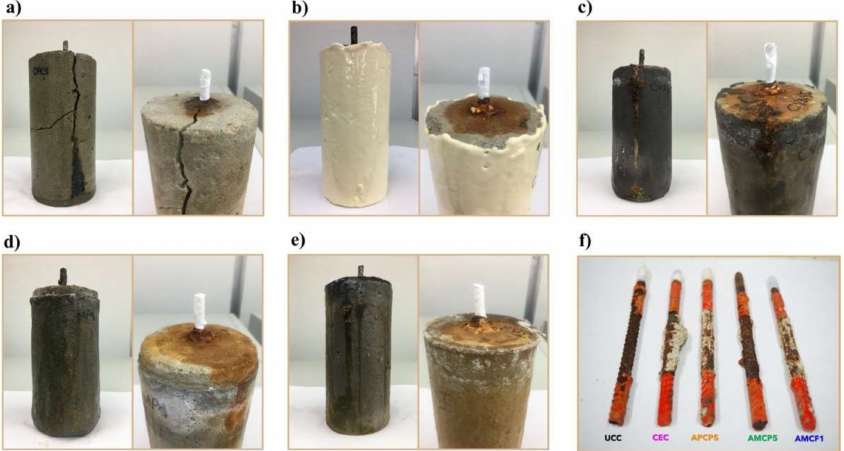
Figure 3. Coated and uncoated reinforced concrete samples submitted to impressed voltage test: ( a ) UCC sample; ( b ) CEC sample; ( c ) AMCF1 sample; ( d ) AMCP5; ( e ) APCP5; and ( f ) steel bars after the test. Reprinted from [54], with permission from Elsevier (November